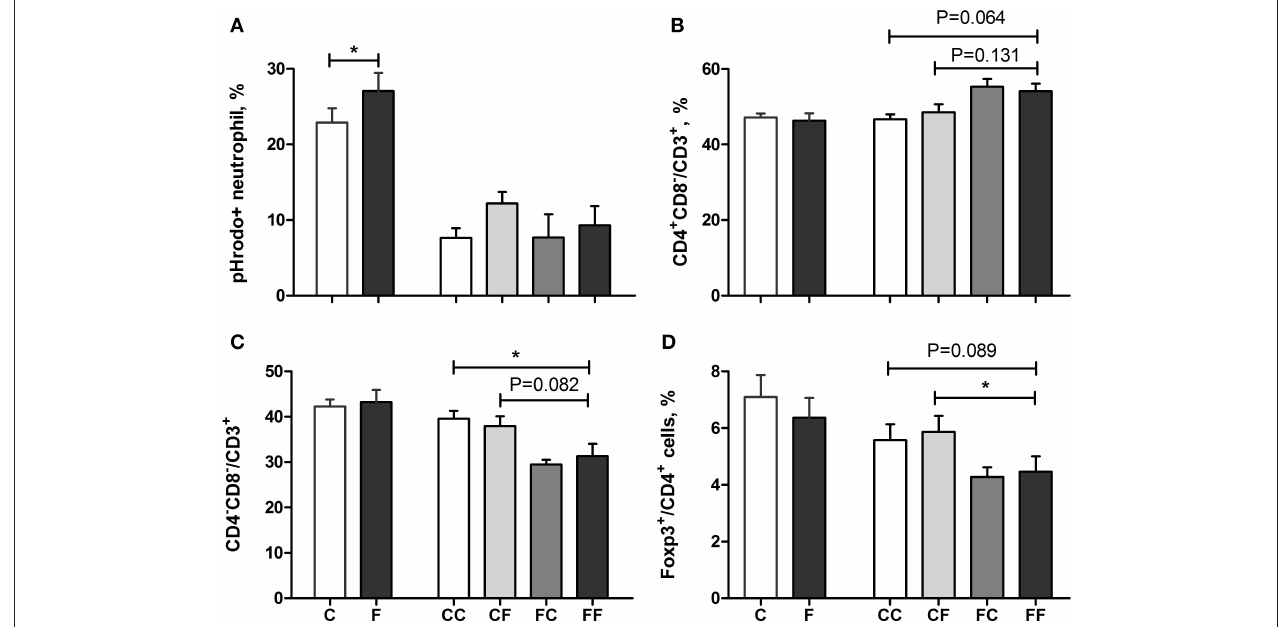
FIGURE 3 | Systemic immunity, including neutrophil function and blood T-cell subsets. Neutrophil phagocytic rate (A) , T h frequency (B) , DN frequency (C) , and T reg frequency (D) . n = 21–27 for C and F groups and n = 4–8 for CC, CF, FC, and FF groups. Values (means ± SEM) designated with asterisks are significantly different, * P < 0.05; T h , helper T cells. DN, double-negative T cells; T reg , regulatory T cells; C, colostrum feeding for the first 4 days; CC, colostrum feeding until day 9; CF, 4 days colostrum feeding followed by formula feeding until day 9; F, formula feeding for the first 4 days; FC, 4 days formula feeding followed by colostrum feeding until day 9; FF, formula feeding until day